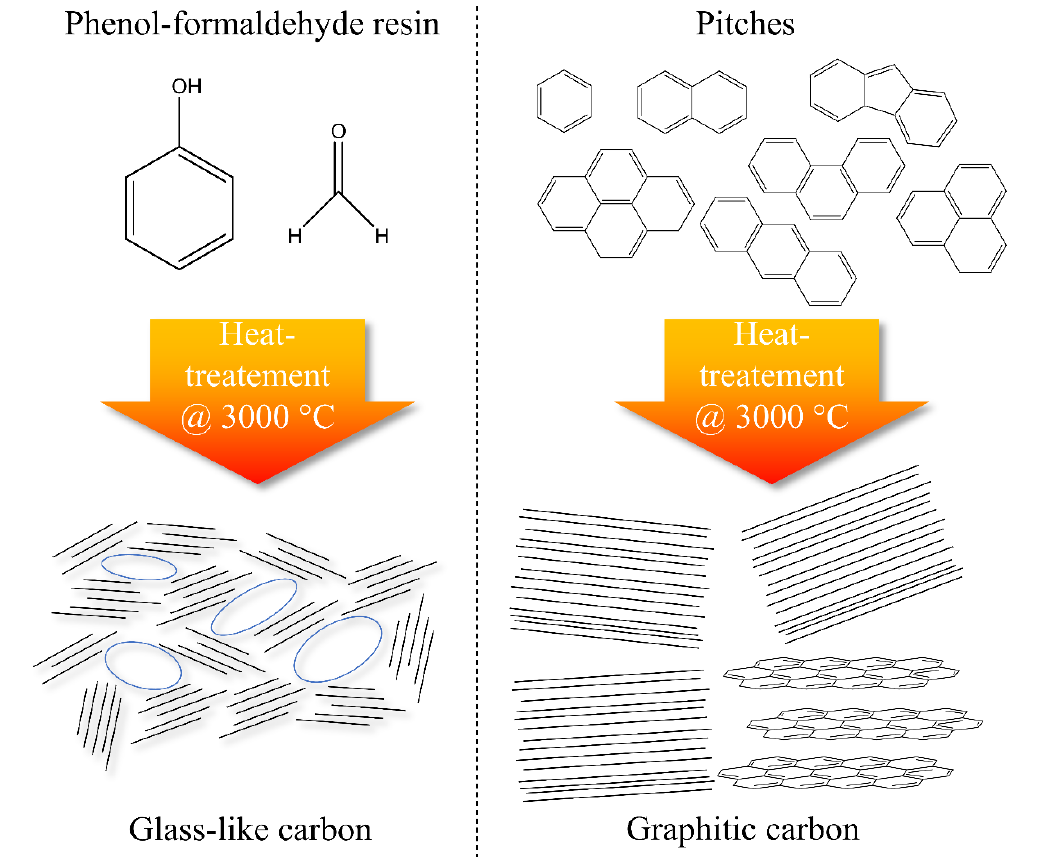
Figure 6. Schematic representation of the two types of precursors used. Phenol-formaldehyde resins form slightly porous glass-like carbons at high temperatures, while pitches, especially low softening-point pitches, can form graphite at very high temperatures.